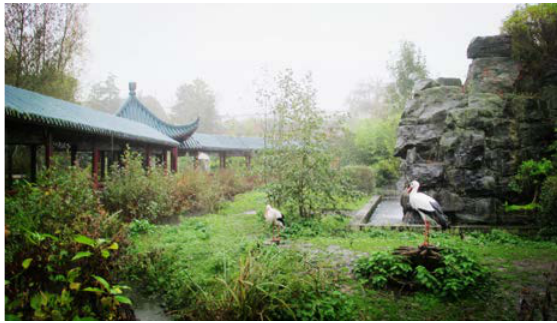
Figure 4.the animals in Pairi Daiza